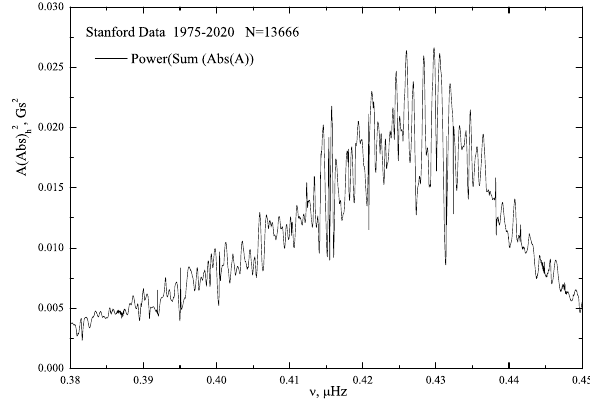
Figure 8. PS of the MMF, calculated by formula (6), in the region of the periods of the Sun’s rotation.